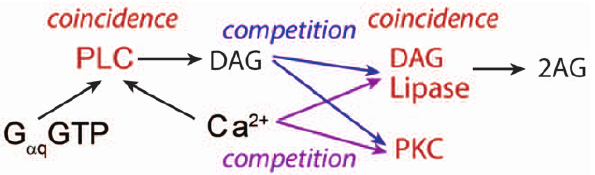
Figure 4. Simplified schematic of signaling pathways demon- strating the three coincidence detection molecules (red): PLC, DAG lipase and PKC, and that DAG lipase and PKC compete for calcium (purple arrows) and DAG (blue